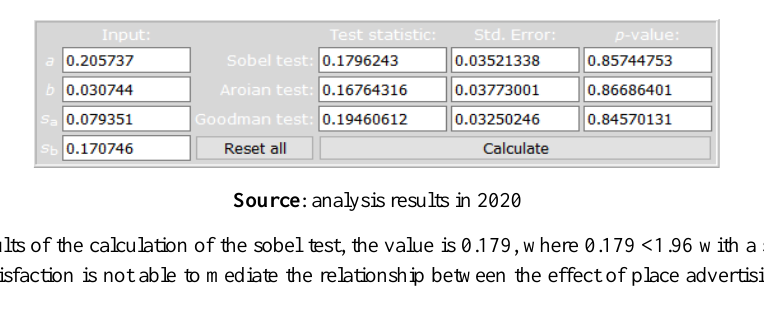
Table 9: Sobel test Place advertising Against Positive word of